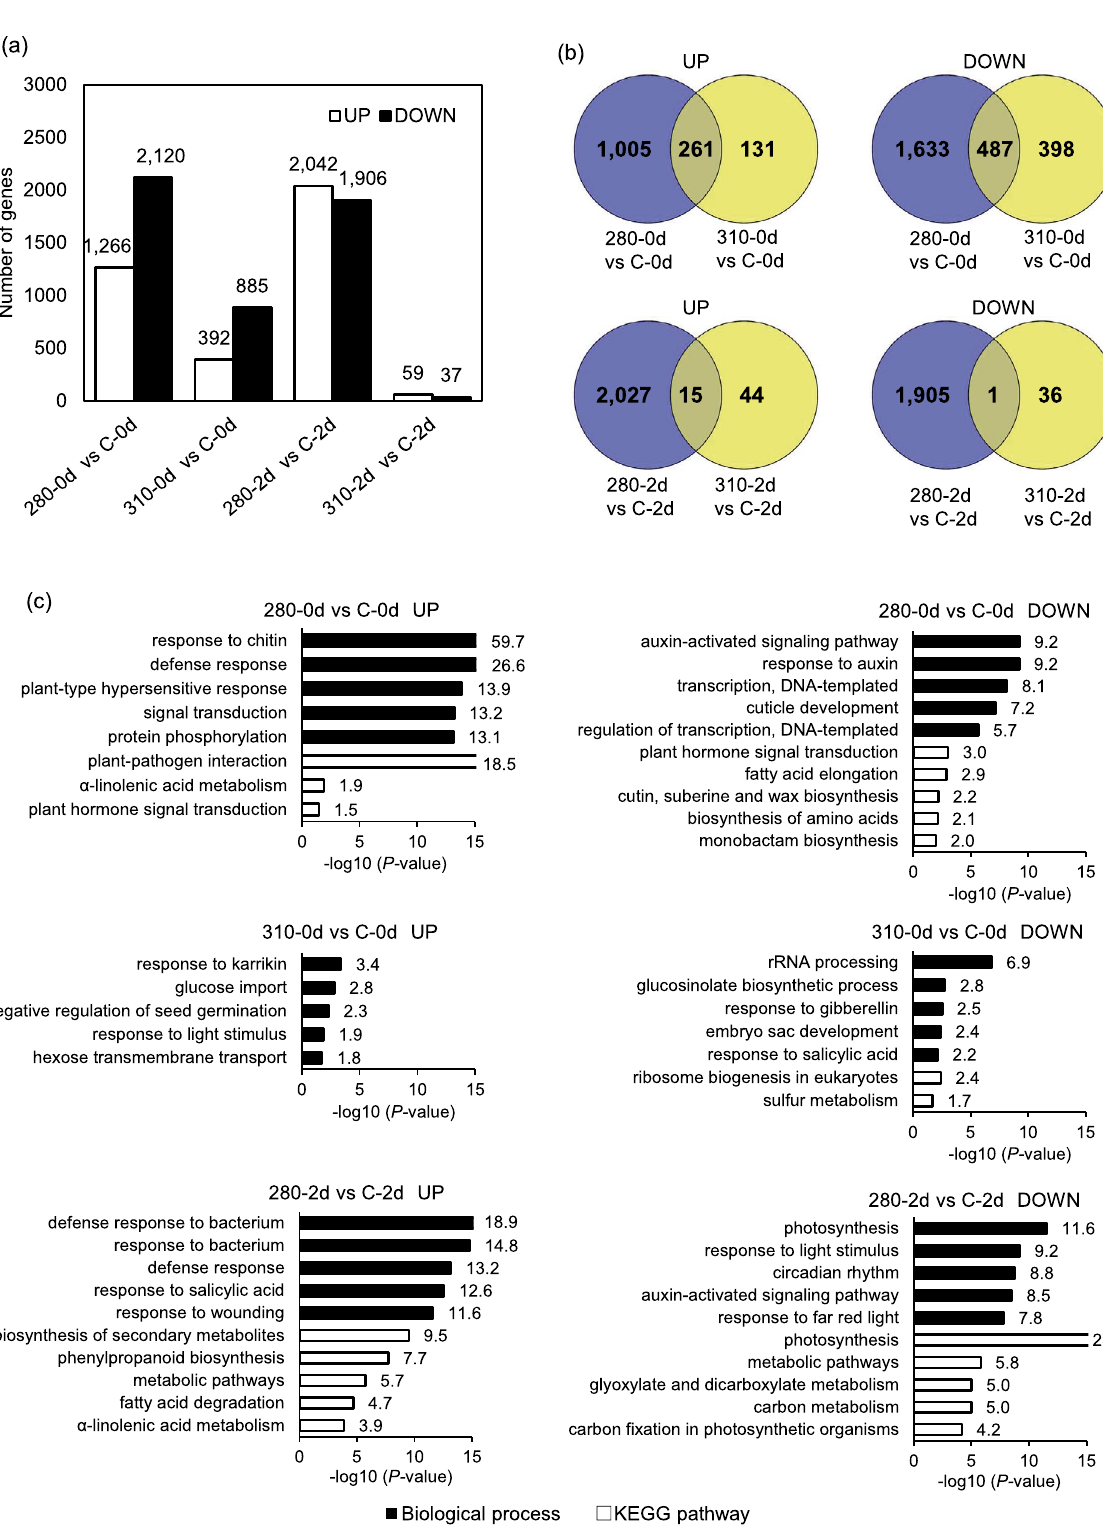
Figure 1. Overall description of transcriptome data. ( a ) Comparison of up-regulated and down-regulated numbers of DEGs under 280 and 310 nm UV. Welch’s t -test was applied for comparison of UV-irradiated samples with control, and a gene with a P -value less than 0.05 and a two-fold change was considered as a DEG. ( b ) Venn diagrams illustrating the shared and unique up-regulated and down-regulated DEGs between samples under 280 and 310 nm UV-B. ( c ) Gene ontology enrichment analysis of up-regulated and down-regulated DEGs in biological processes and Kyoto Encyclopedia of Genes and Genomes pathway using DAVID ver. 6.8. Top five terms were selected according to the P -values when more than five terms were